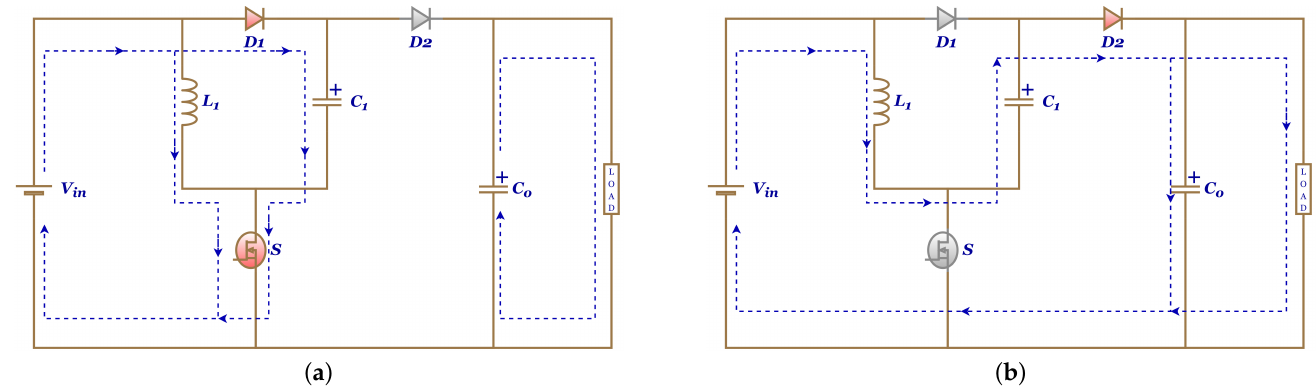
Figure 16. PSOL operation: ( a ) S closed, and ( b ) S open.